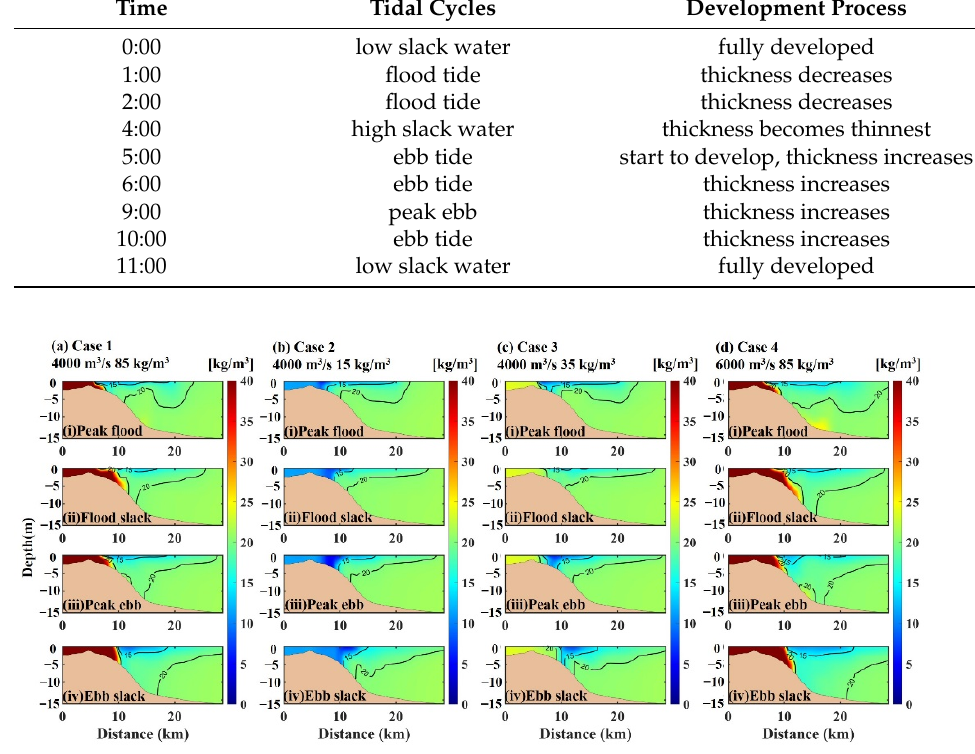
Figure 10. Vertical profiles of excess bulk density along the axial section P1 at different times: Note that Figures 10a ‐ d represent Case 1 ‐ 4, respectively whereas ( i ) peak flood; ( ii ) flood slack; ( iii ) peak ebb; ( iv ) ebb slack.